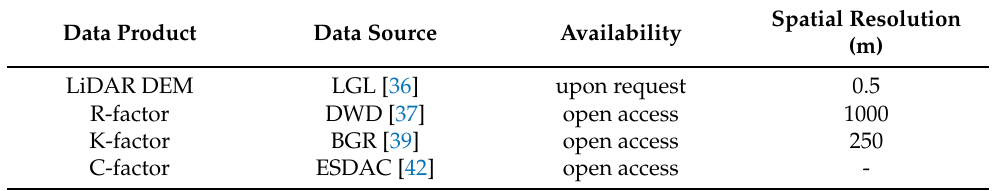
Table 1. Basic USLE factor data product acquisition and